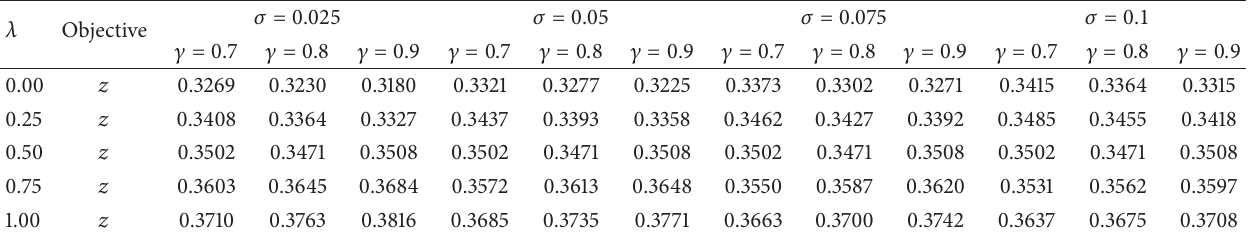
Table 10: Sensitivity analysis on optimistic-pessimistic index and probability-possibility levels.